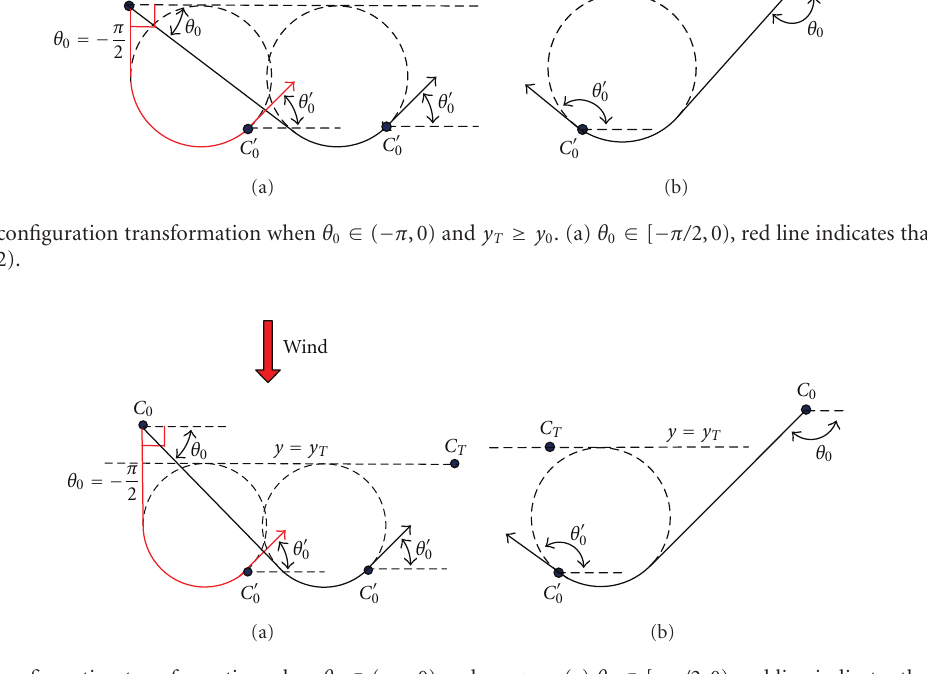
Figure 15: Initial configuration transformation when θ 0 ∈ ( − π ,0) and y T < y 0 . (a) θ 0 ∈ [ − π/ 2,0), red line indicates that θ 0 = − π/ 2 and (b) θ 0 ∈ ( − π , − π/ 2).